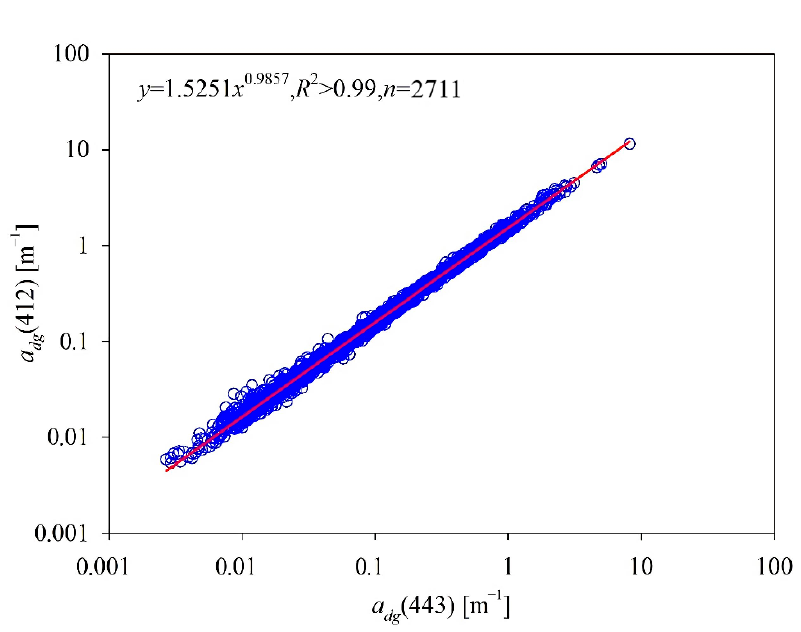
Figure 1. Empirical relationship between a dg (412) and a dg (443).